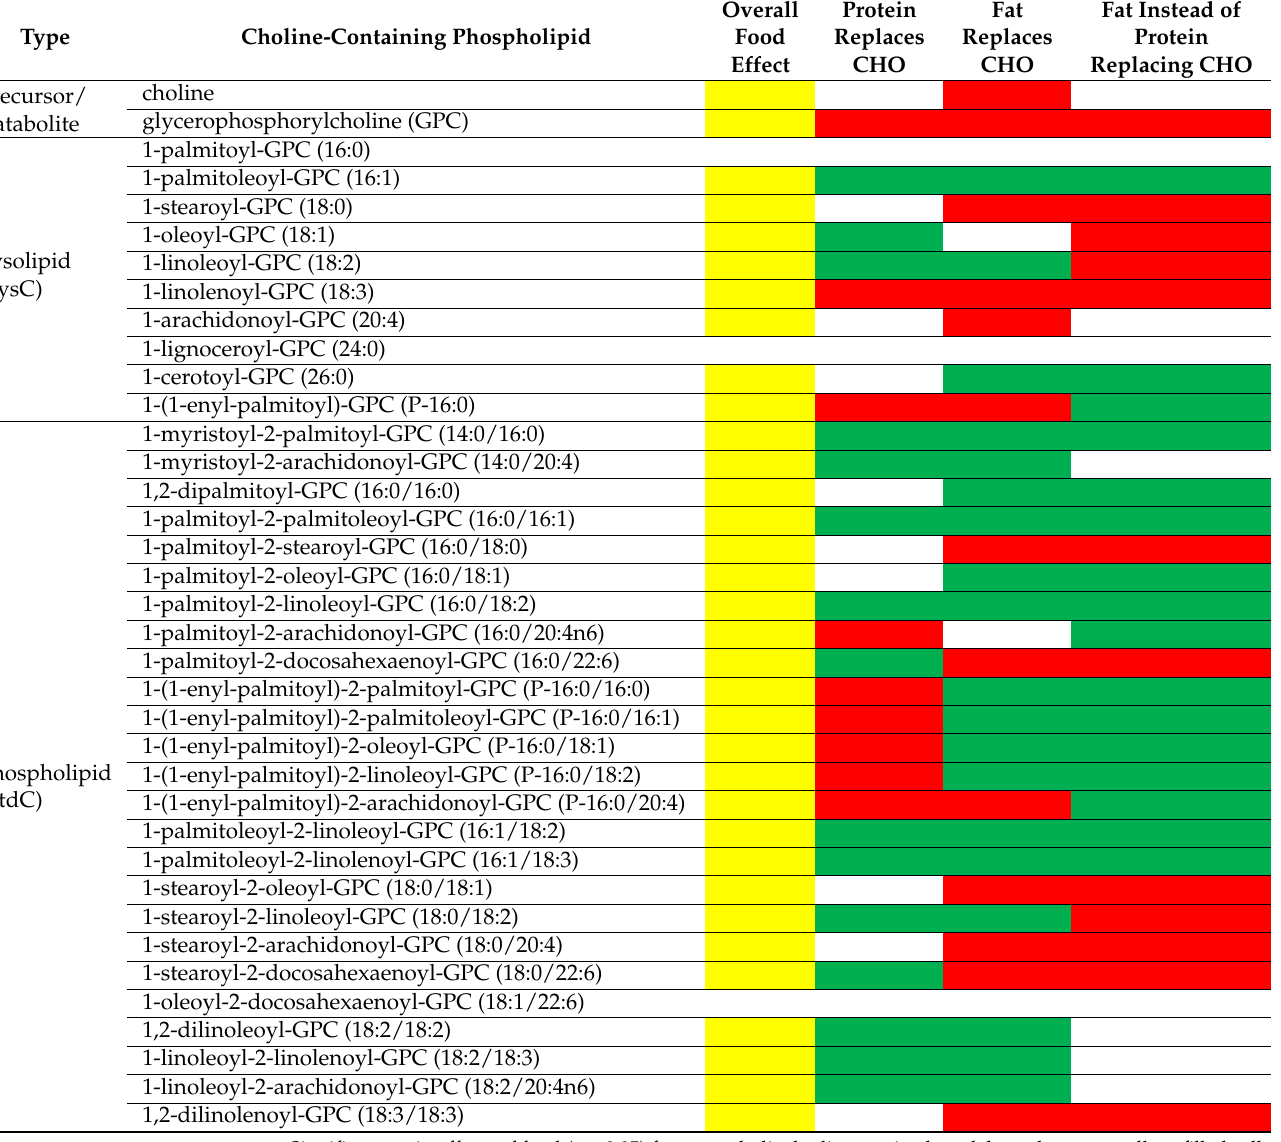
Table 11. Effects of foods on serum choline-containing